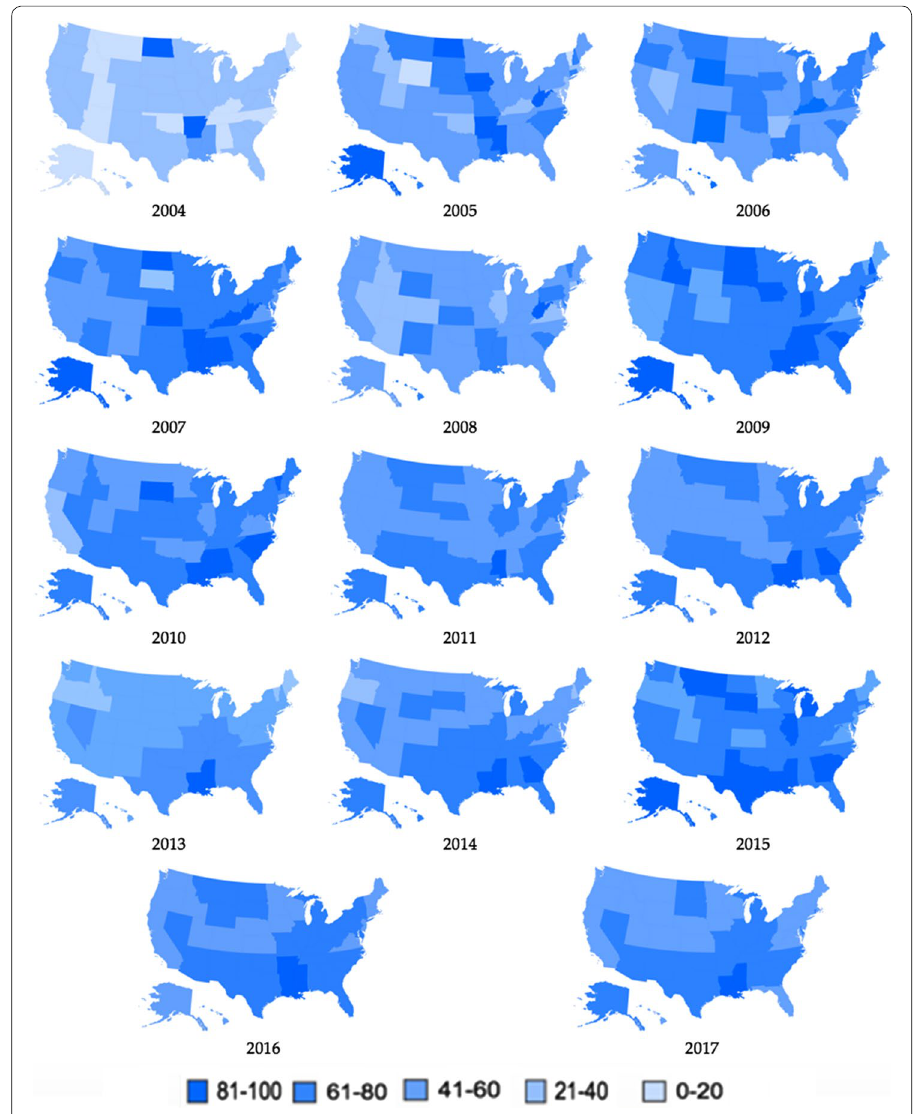
Fig. 2 Online interest heat maps for the term ‘Chlamydia’ by state by year